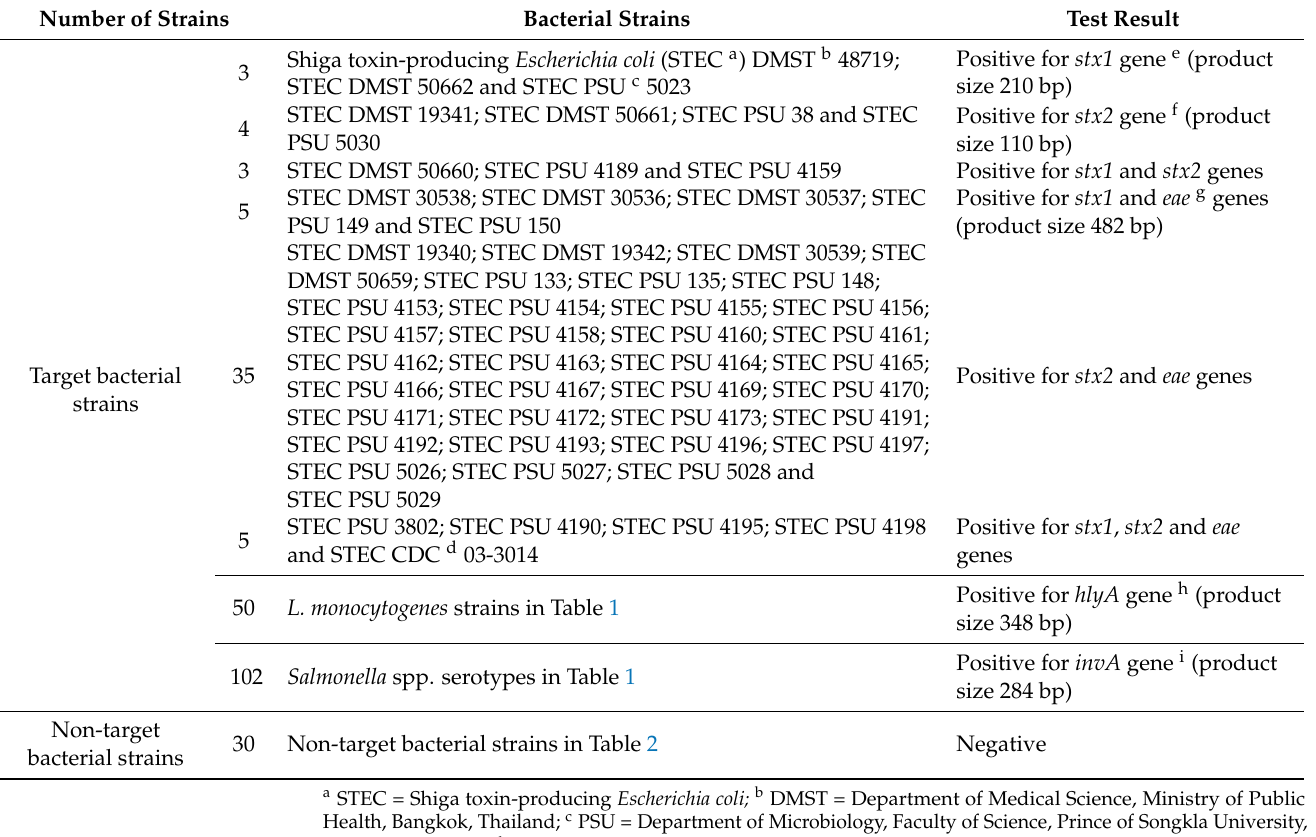
Table 4. Inclusivity and exclusivity of the developed mPCR assay for specific detection of three target bacteria.